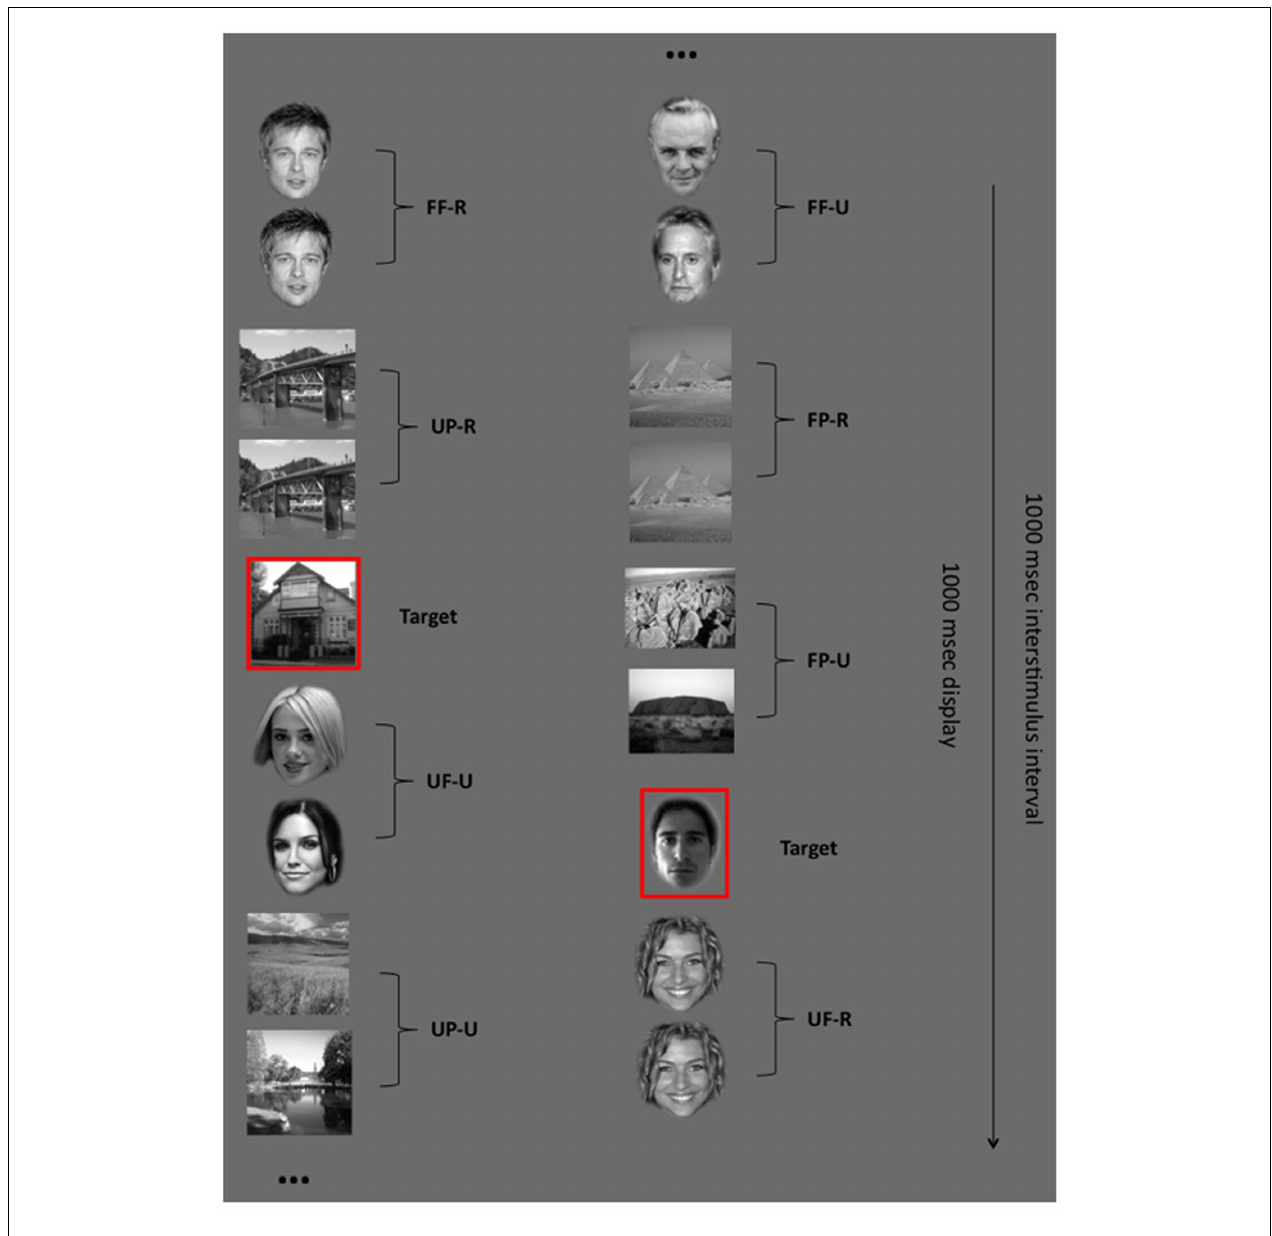
unfamiliar faces repeated; UF-U: unfamiliar face unrepeated; FP-R: familiar place repeated; FP-U: familiar place unrepeated; UP-R: unfamiliar place repeated; UP-U: unfamiliar place unrepeated).The superimposed red fixation cross that was present during the experiment is not indicated in this figure for clearer viewing of the